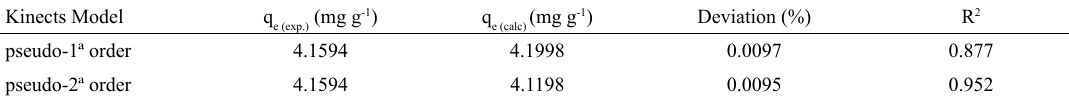
Table 3. Concentration of equilibrium in the determined solid phase, applying the pseudo-first-order model, pseudo-second order, obtained experimentally. Kinects Model